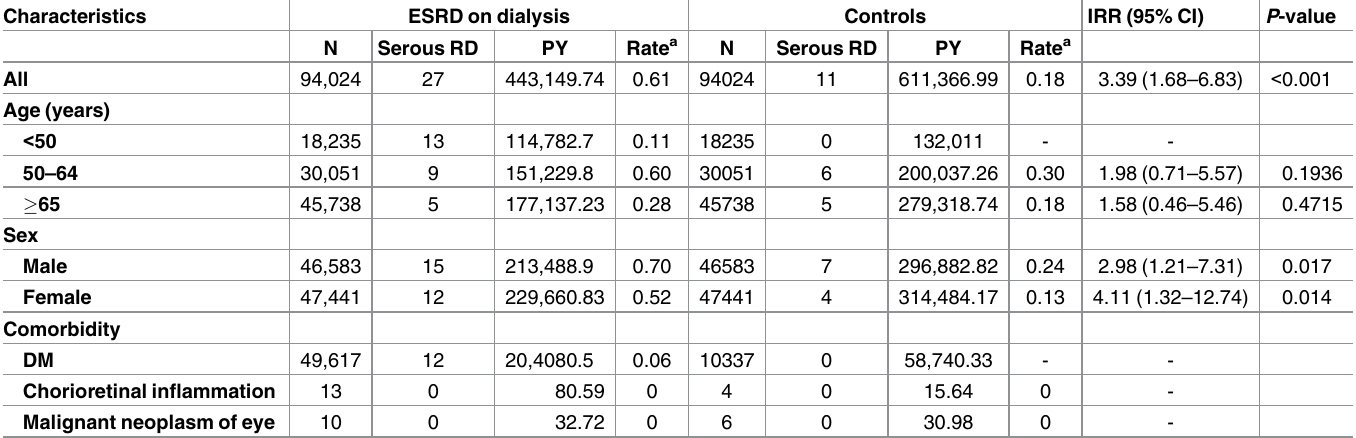
Table 2. Risk of serous retinal detachment in the ESRD on dialysis and control groups. Characteristics